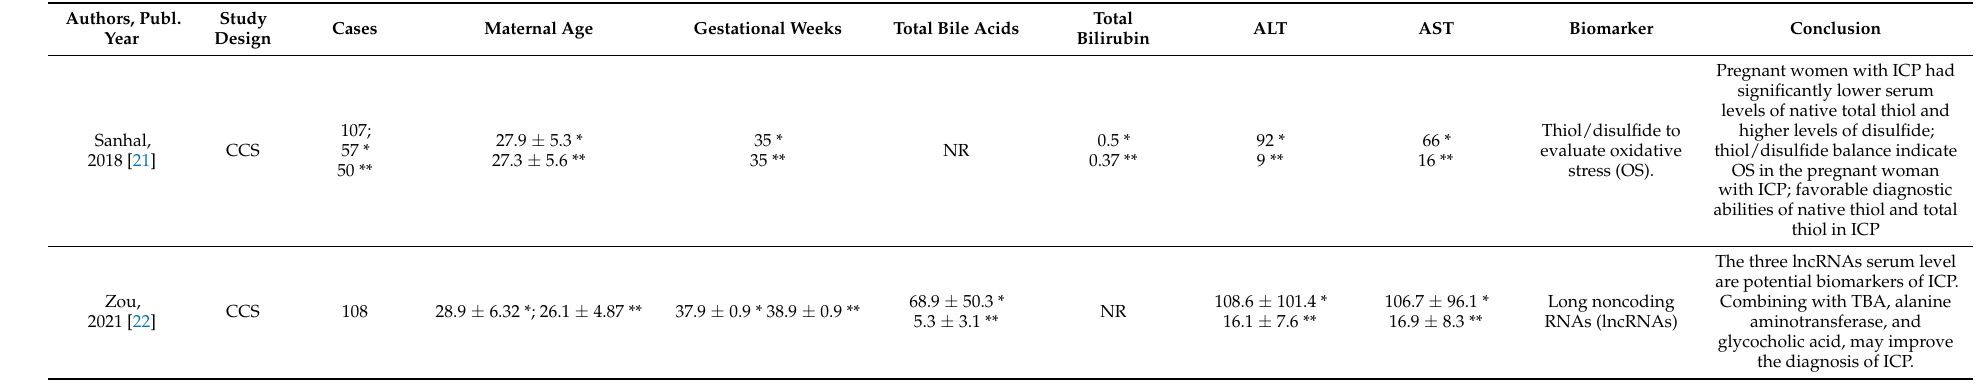
Table 4. Main RCT/CT studies for treatment in HELLP, ICP and AFLP. I = group A, II = group B. PPC-Polyunsaturated phosphatidylcholine; SAMe-S-adenosylmethionine. Authors, Publ.